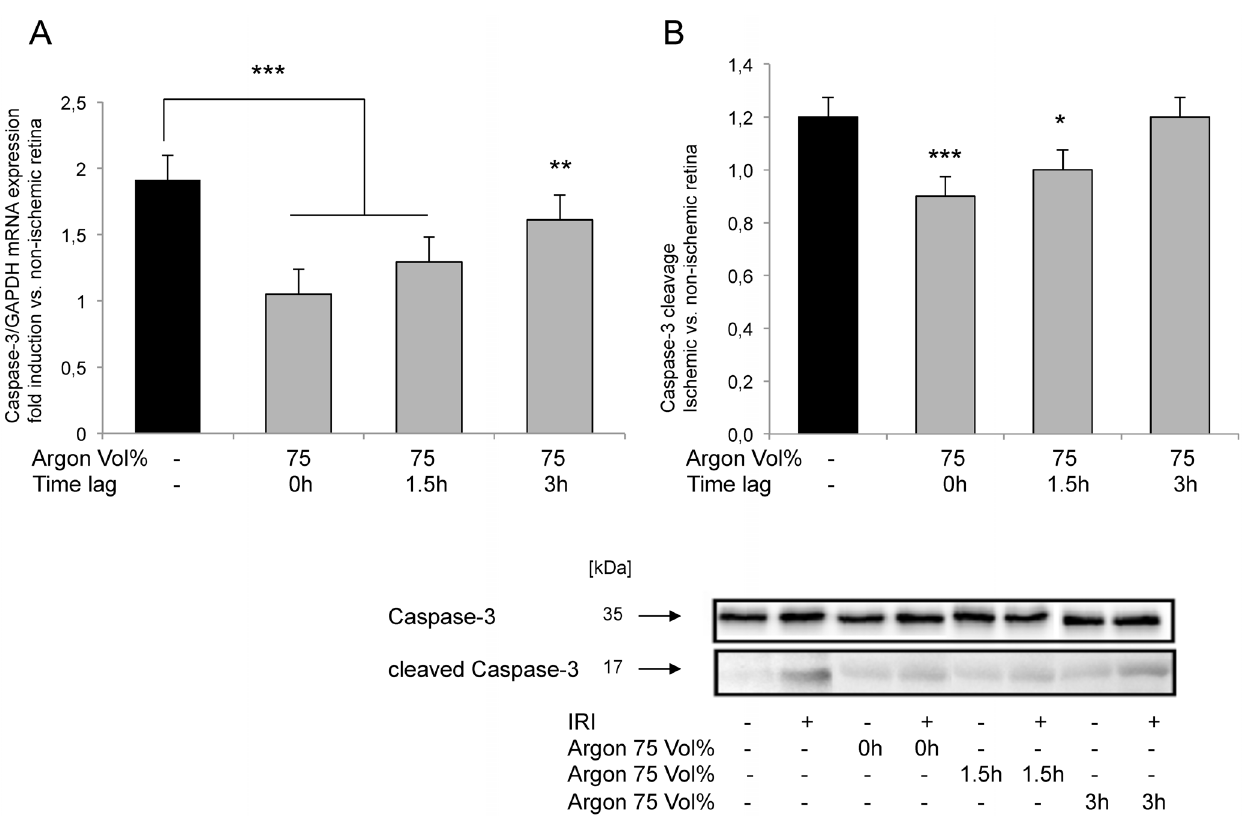
Fig. 3. Effect of Argon inhalation on retinal expression of Caspase-3 mRNA and Caspase-3 cleavage. ( A ) Fold induction of Caspase-3 mRNA expression after time-dependent inhalation of Argon 75 Vol% in ischemic retinal tissue compared to GAPDH in relation to the corresponding non-ischemic retinae analyzed by RT-PCR (n 5 8; data are mean ¡ SD; *** 5 p , 0.001 IRI vs. IRI + Argon immediately and at 1.5 h delayed treatment and ** 5 p , 0.01 IRI vs. IRI + Argon at 3 h delayed treatment). ( B ) Densitometric analysis of n 5 8 western blots for caspase-3 cleavage after time-dependent inhalation of Argon 75 Vol% (data are mean ¡ SD; *** 5 p , 0.001 IRI vs. IRI + Argon immediately and * 5 p , 0.05 IRI vs. IRI + Argon at 3 h delayed treatment) and representative western blot image (n 5 8) showing the suppression of retinal cleavage of caspase-3 compared to uncleaved caspase-3.